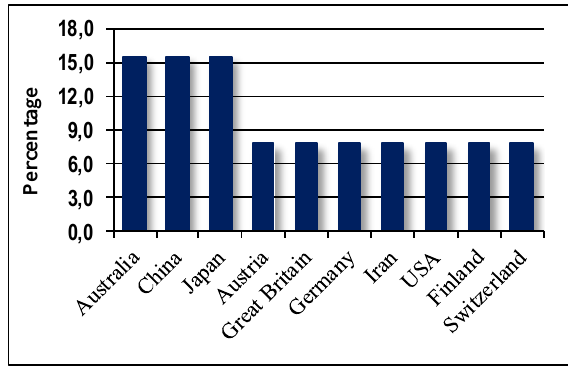
Figure 11. Countries that made major contribution in research related to Data bases: automatic acquisition, processing, storage and updating of spatial data (2012)